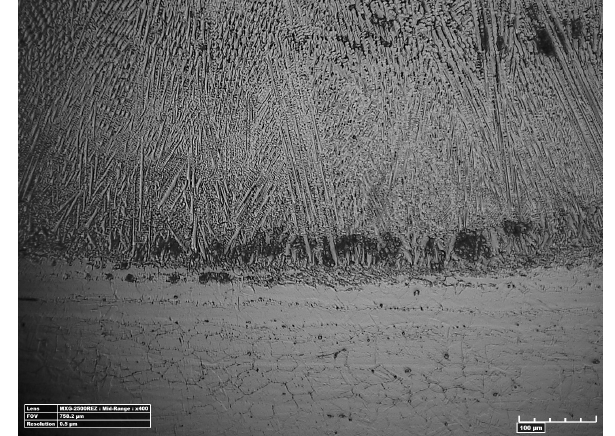
Figure 8: Structure of substrate and deposited Inconel 625